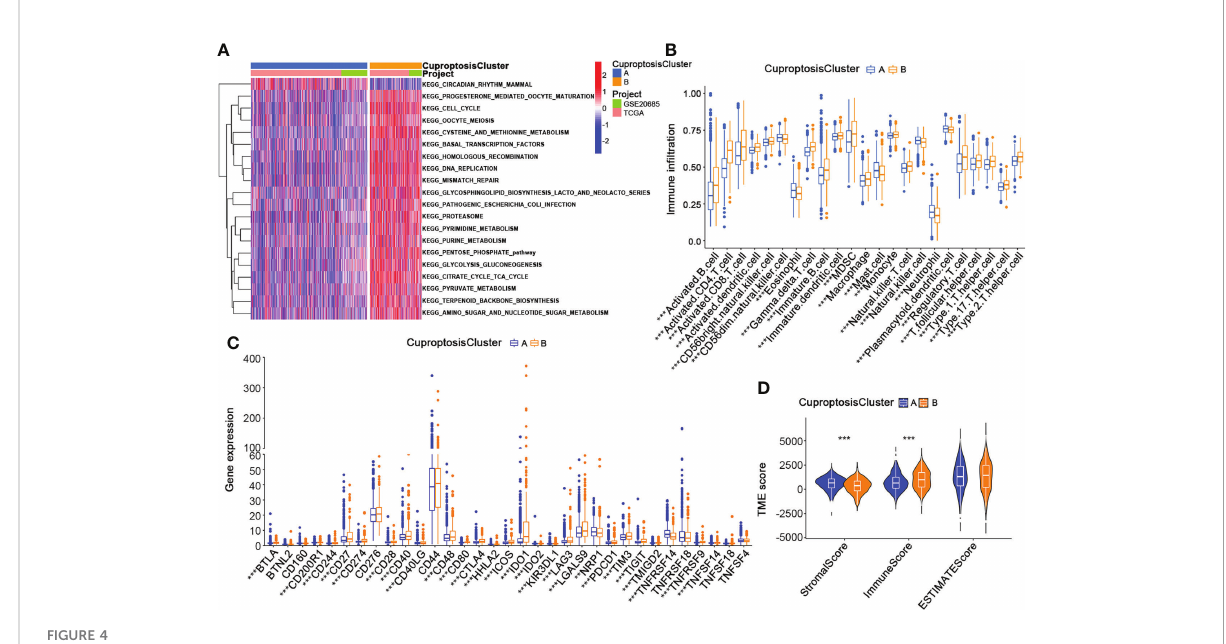
FIGURE 4 Characteristics of the TME in CuproptosisClusters of BRCA. (A) The GSVA of biological pathways between the two CuproptosisClusters (Spearman test, blue: inhibited pathways; red: activated pathways). (B) The abundance of 23 in fi ltrating immune cell types in the two CuproptosisClusters (Spearman test). (C) The expression levels of 32 immune checkpoints in the two CuproptosisClusters (Wilcoxon test). (D) The TME score of the two CuproptosisClusters (Spearman test). GSVA, gene set variation analysis; TME, tumor microenvironment. ** p < 0.01, *** p <